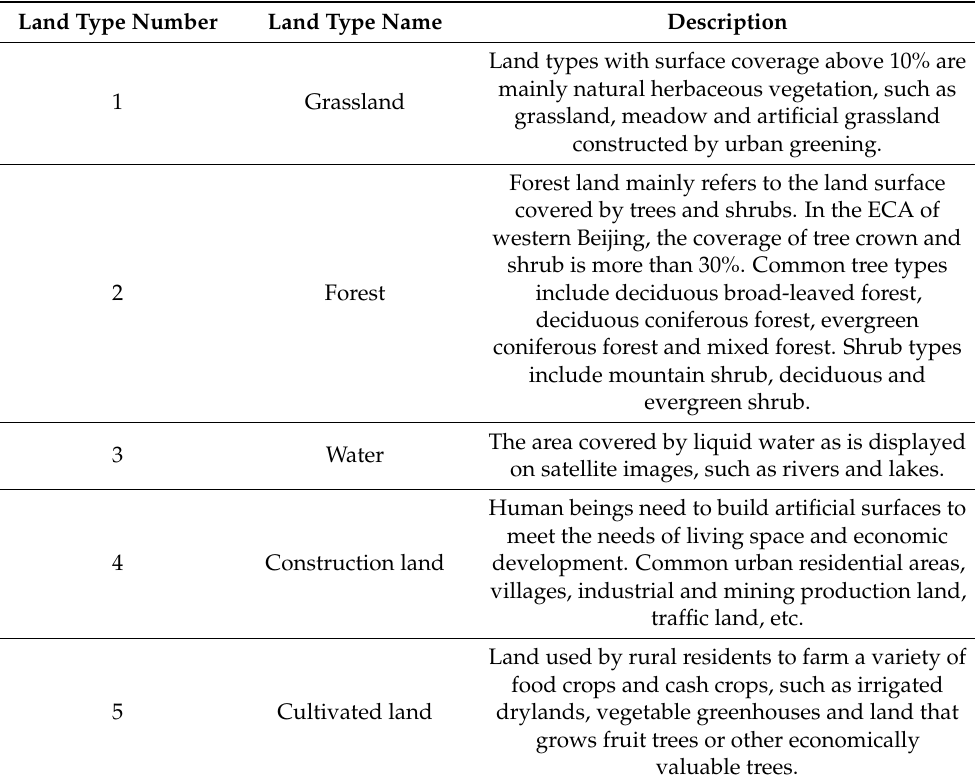
Table 1. Land-use type classification for the ECA in western